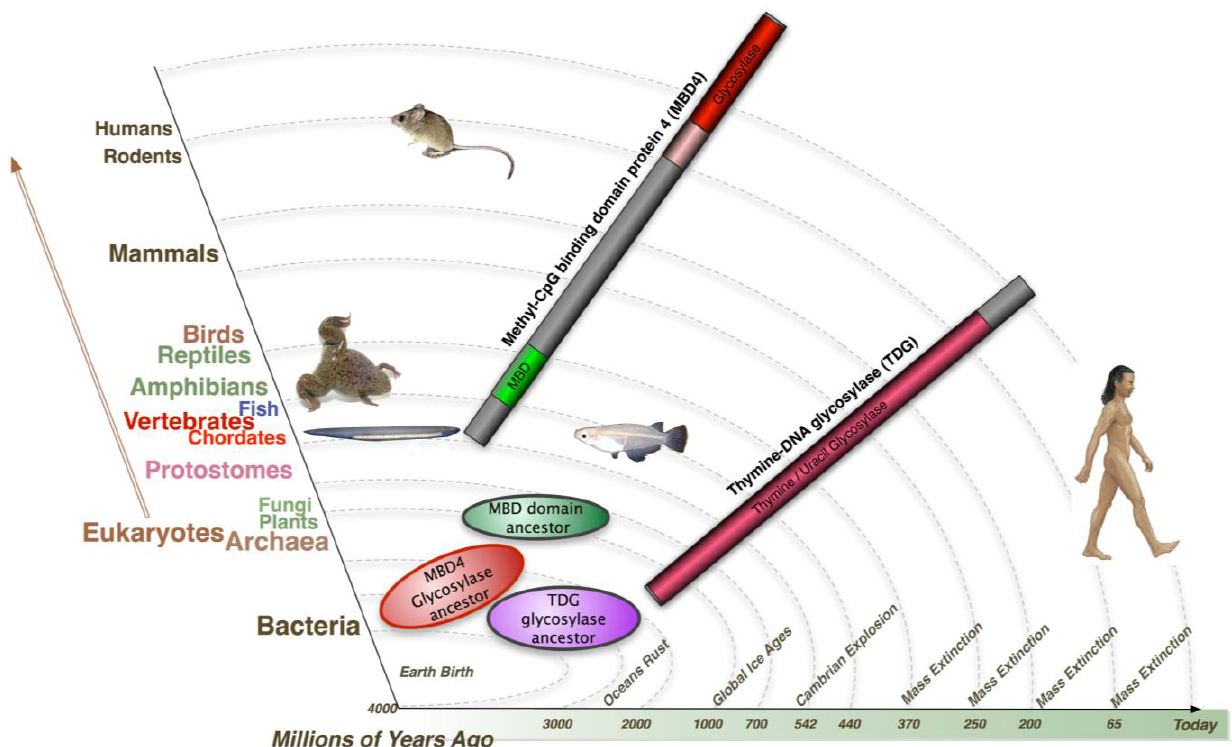
Figure 4. Evolutionary timeline of the two mammalian Thymine glycosylase proteins: Methyl-CpG binding domain protein 4 and Thymine-DNA glycosylase (TDG). The ortholog of proteins including the MBD domain and the glycosylase domain of human MBD4 and of full length human TDG were inferred initially by reciprocal best BLASTP searches against the non-redundant protein sequences database, and confirmed by phylogenetic reconstructions. Neighbor-joining (NJ) phylogenetic trees were constructed for domains of MBD4 and full length TDG proteins. Maximum likelihood (ML) analyses were performed using the PHYML module from Geneious pro software, following the JTT model of amino acid substitution. Protein domains were identified using InterProScan and Conserved Domains servers. Published procedures for this bioinformatic approach were followed [99]. Both glycosylase ancestors of MBD4 and TDG were found in Bacteria. Glycosylase ancestors of MBD4 were found in Archaea, whereas only a hypothetical TDG Archaea ortholog was identified. Both glycosylase ancestors of MBD4 and TDG were found in Plants and Fungi, in contrast, the earliest MBD domain ancestors were in plants and not in Fungi. TDG protein was found in almost all the species throughout evolution, the full length MBD4 though, emerges as a fusion protein only from Chordates: the representative of Invertebrate-Vertebrate